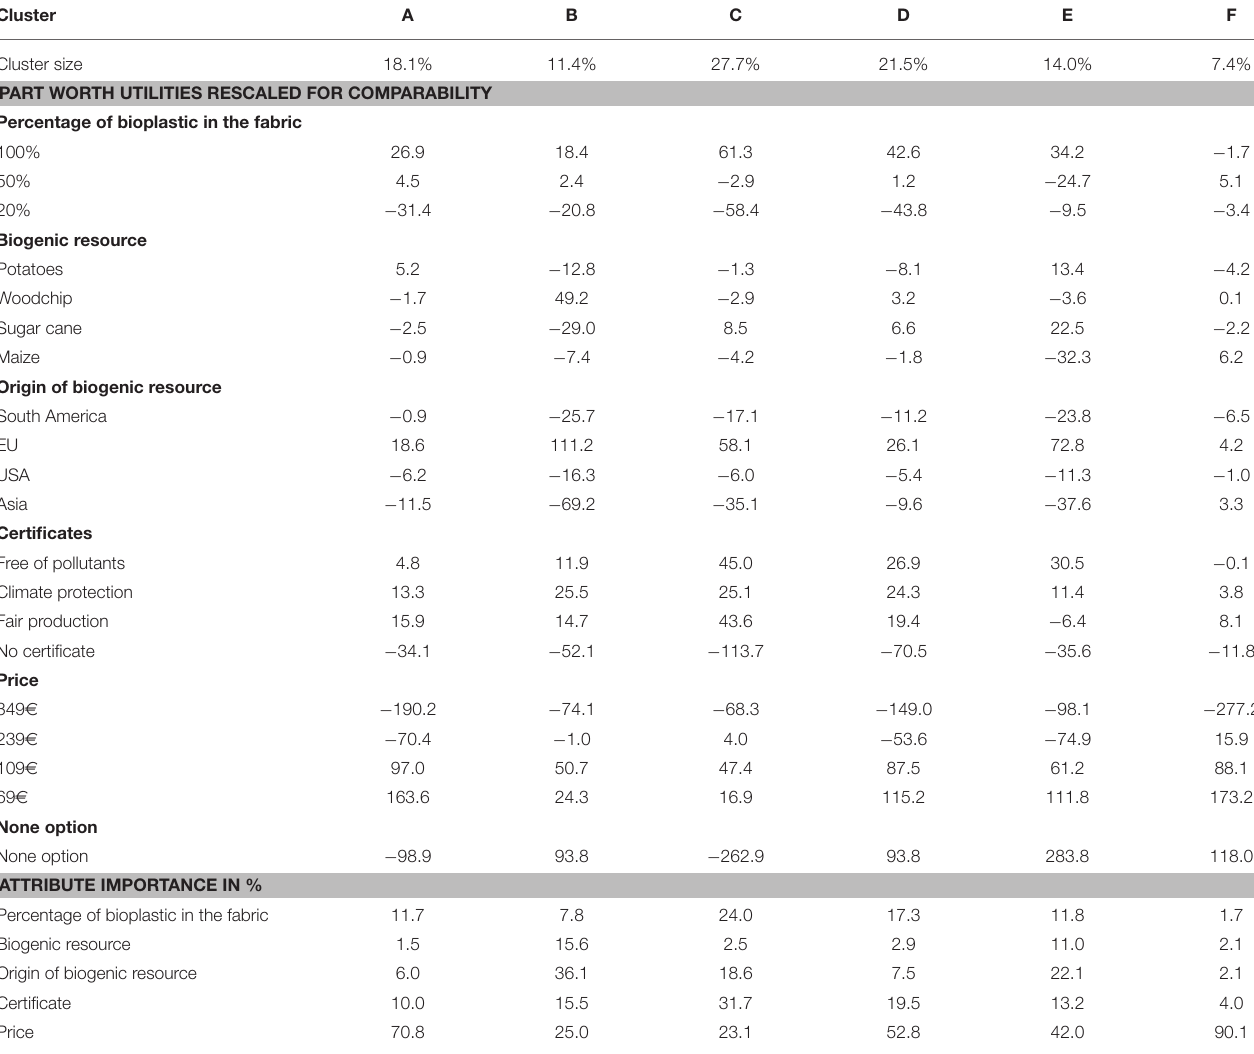
TABLE 5 | Clusters of the latent class analysis.